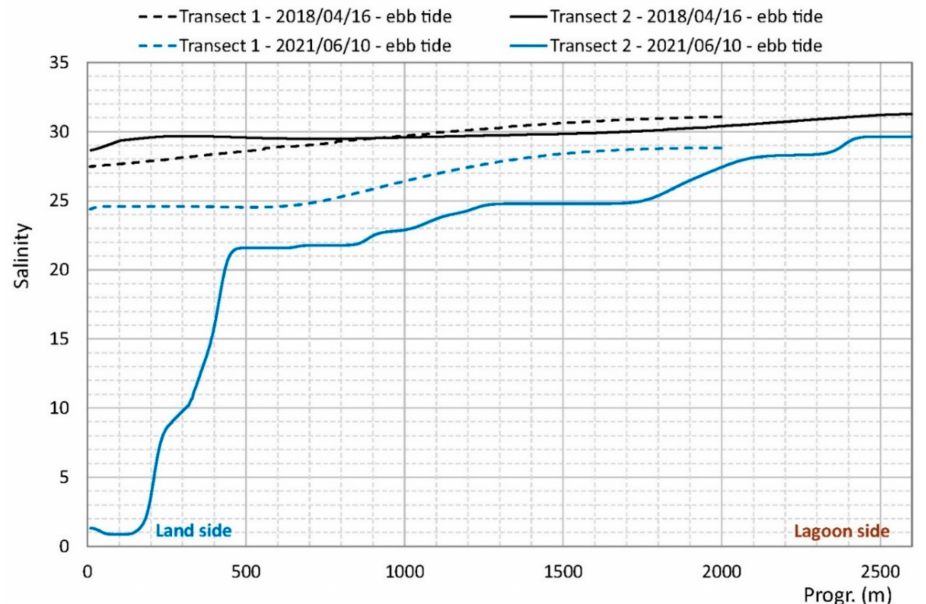
Figure 10. Variation of mean surface salinity along spatial transect 1 and 2 comparing the two CTD campaigns without flow (16 April 2018, black lines) and with a discharge of 1000 ls − 1 (10 June 2021, blue lines).